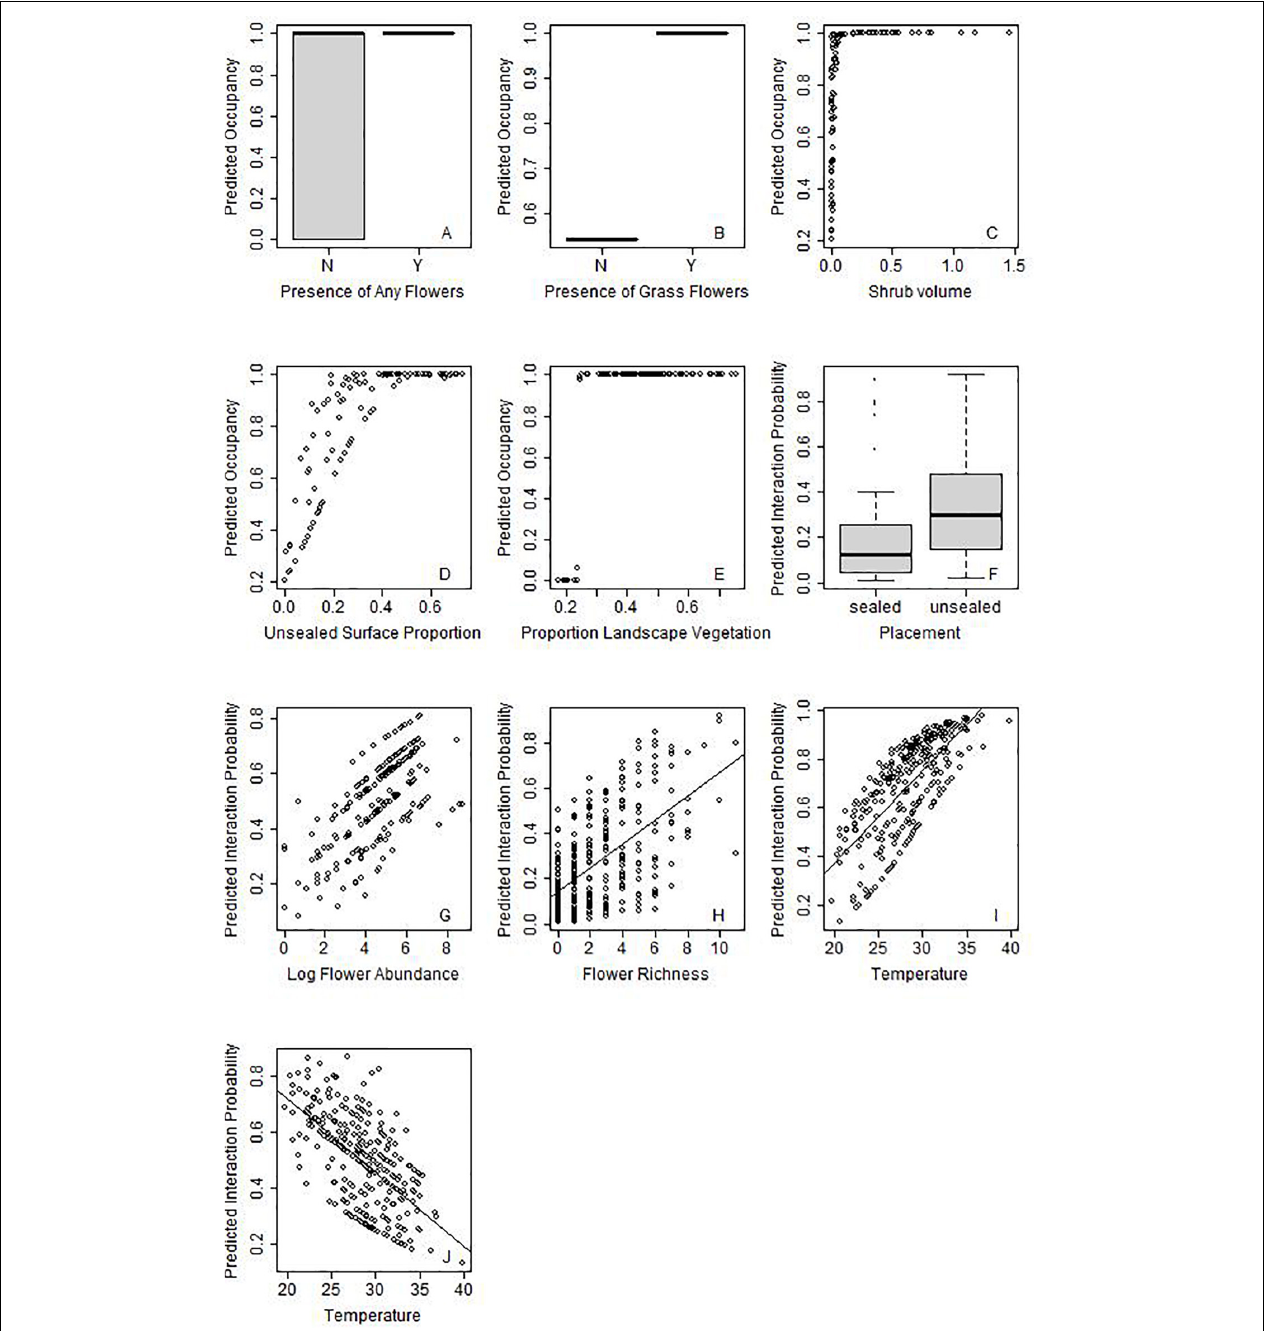
FIGURE 5 | Selected examples of main effects for various pollinator taxa on occupancy probability (A–E) or probability of interaction (F–J) . The pollinator taxa are indicated by the silhouette on the top right of the graph. Figure 4 demonstrates the variables that are significant for each taxon, but for further graphs see Supplementary Figures 1, 2